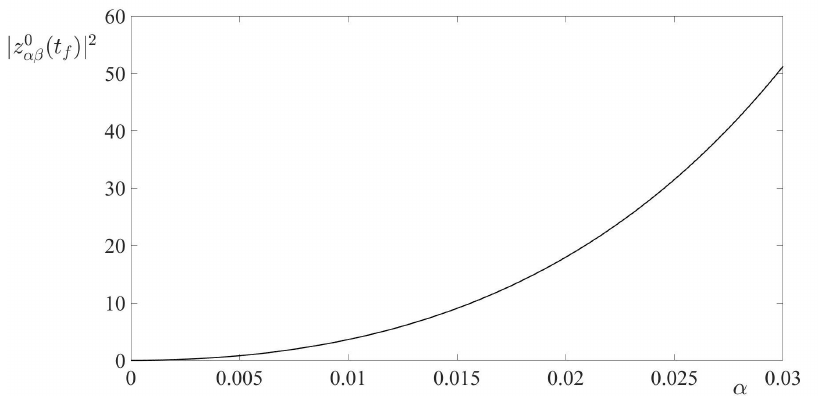
Figure 10. The terminal term of the cost